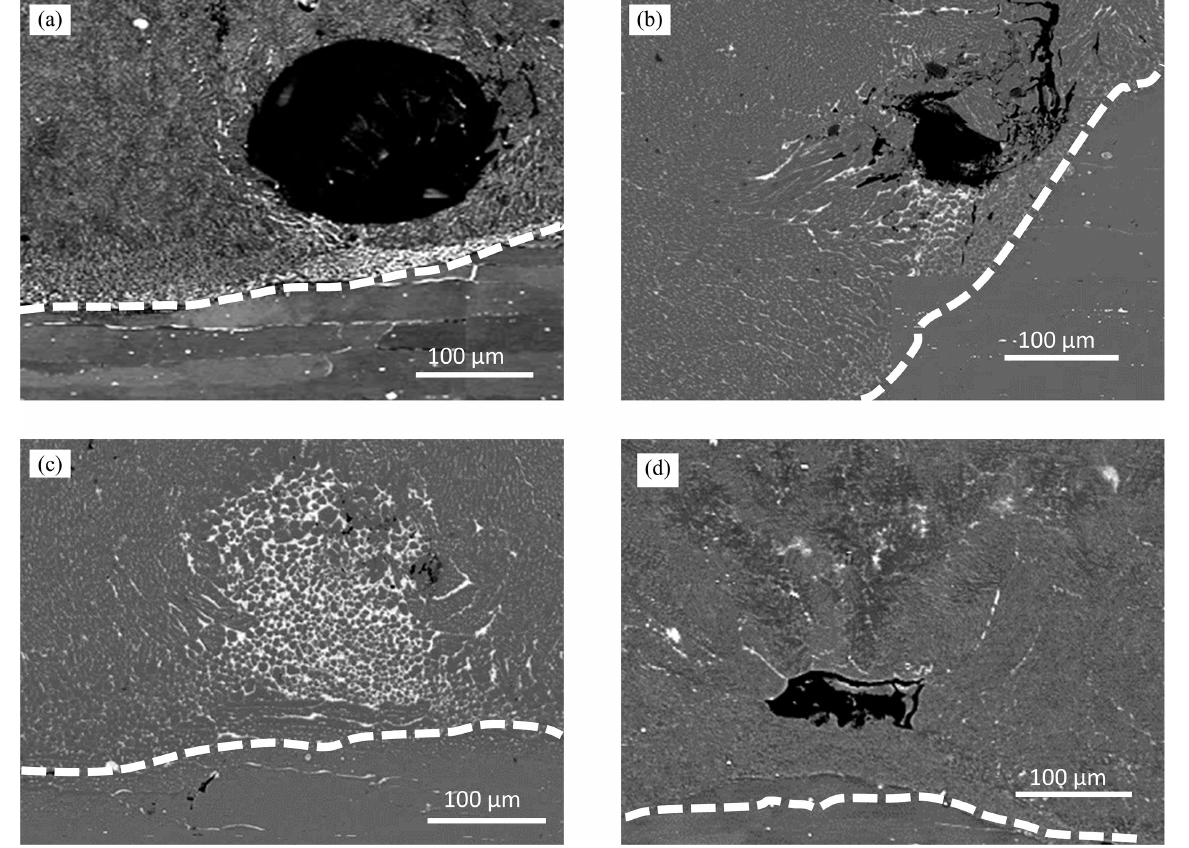
Figure 9: Typical porosities in laser pressure welds produced at varied parameters: (a) A porosity in weld produced at high heat input and low roller pressure; (b) A porosity in weld produced at high heat input and medium roller pressure; (c) A porosity in weld produced at high heat input and high roller pressure; (d) A porosity in weld produced at low heat input and high roller pressure.